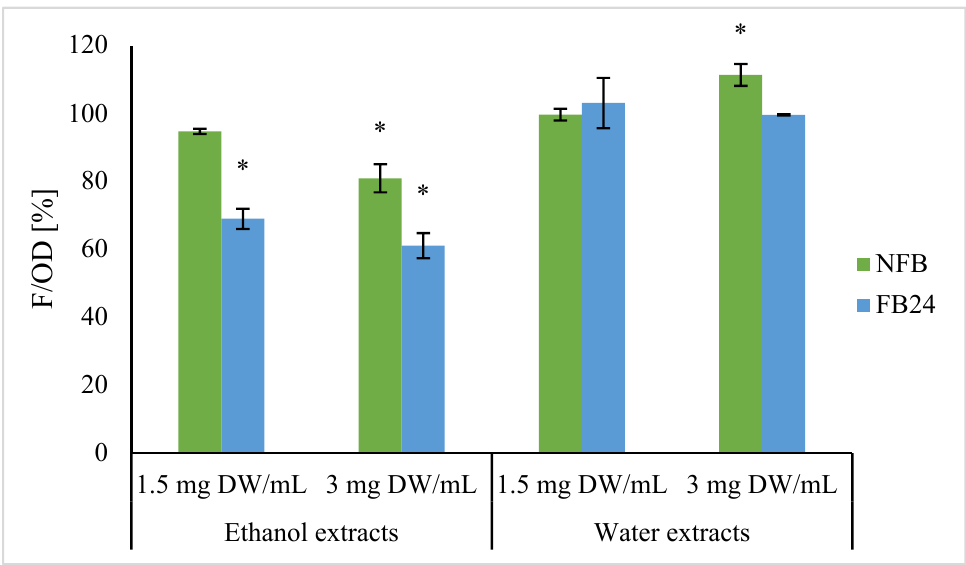
Figure 5. Determination of intracellular oxidation in yeast Saccharomyces cerevisiae exposed to water and ethanol extracts of NFB and FB in concentration of 1.5 and 3.0 mg DW/mL. Data represent mean relative values F/OD to the corresponding control set as 100%. Asterisk (*) indicates statistically significant difference between yeast cells treated with NFB or FB extract and control cells (where water or DMSO was added) for particular extract and concentration ( p < 0.05).